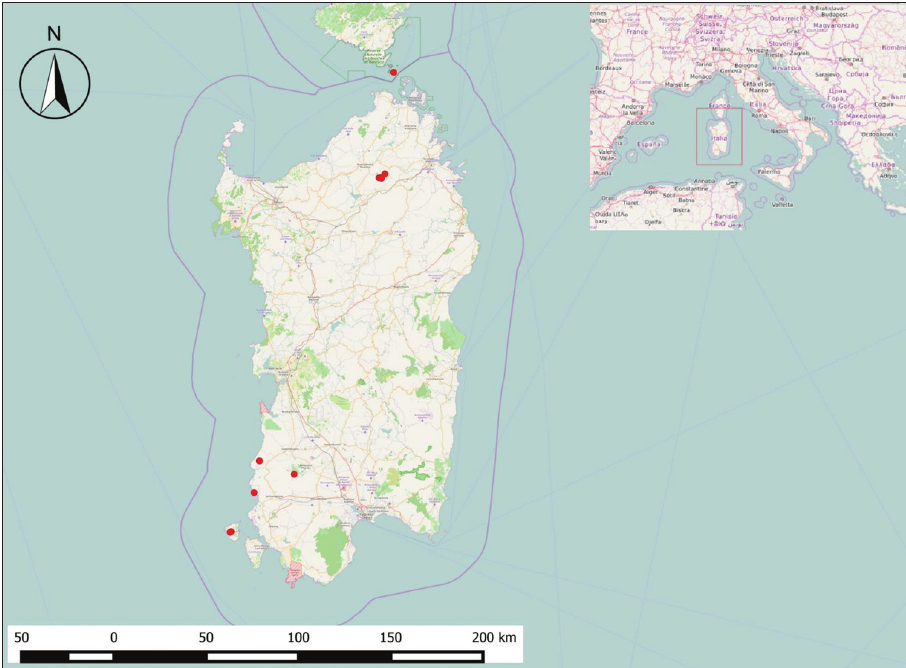
Figure 2. Geographic range and distribution map of Charybdis glaucophylla . num Arrigoni. On sand dunes, this species grows together with various psammophytes, such as Ephedra distachya L., Genista arbusensis Vals. and Scrophularia ramosissima